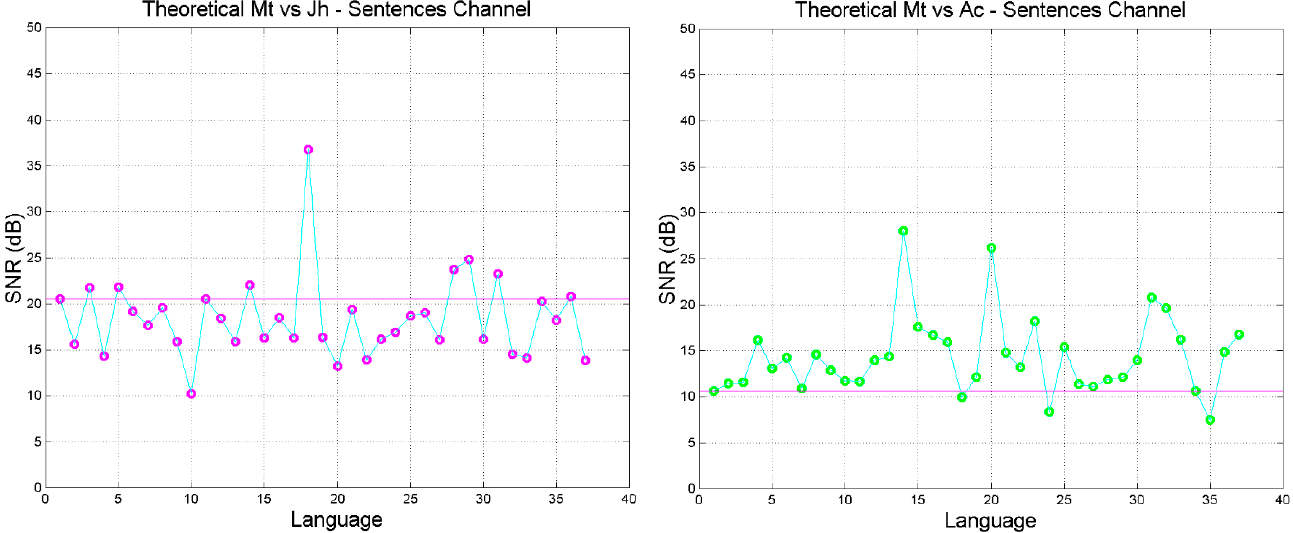
Figure 5. Sentences cross-channel theoretical signal-to-noise-ratio Γ dB in the indicated languages. Languages are ordered according to Table 1. ( Left panel ): Matthew versus John; ( Right panel ): Matthew versus Acts. The magenta line corresponds to Greek (language no.1).